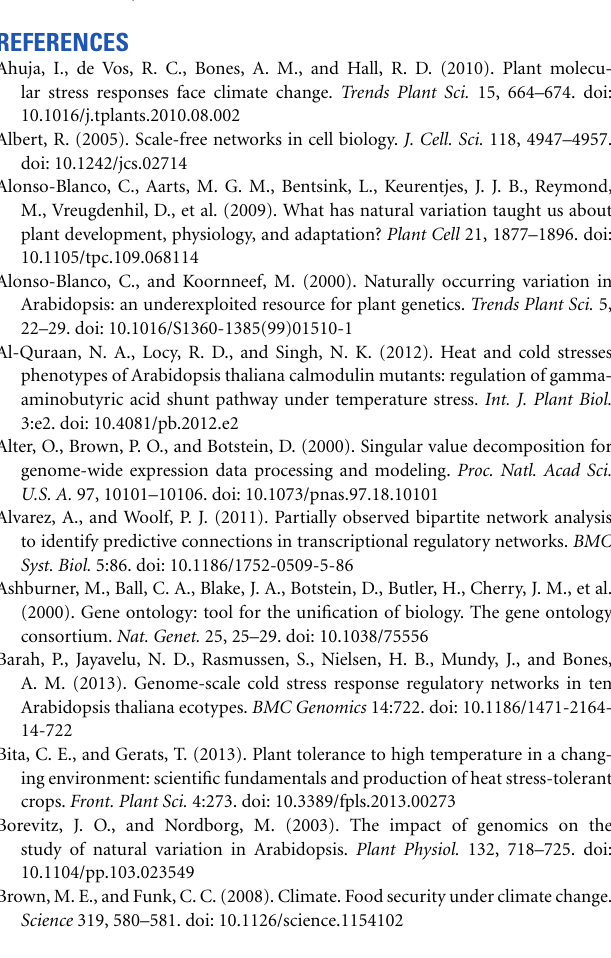
Table S4 | TF-TG regulatory bipartite connections predicted using NCA algorithm. TF-TG regulatory bipartite connections predicted using NCA algorithm based on their expression profiles, using Pearson correlation coefficient threshold (PCC) ≥ 0.80. Annotations and functional roles (TF/TG) are also